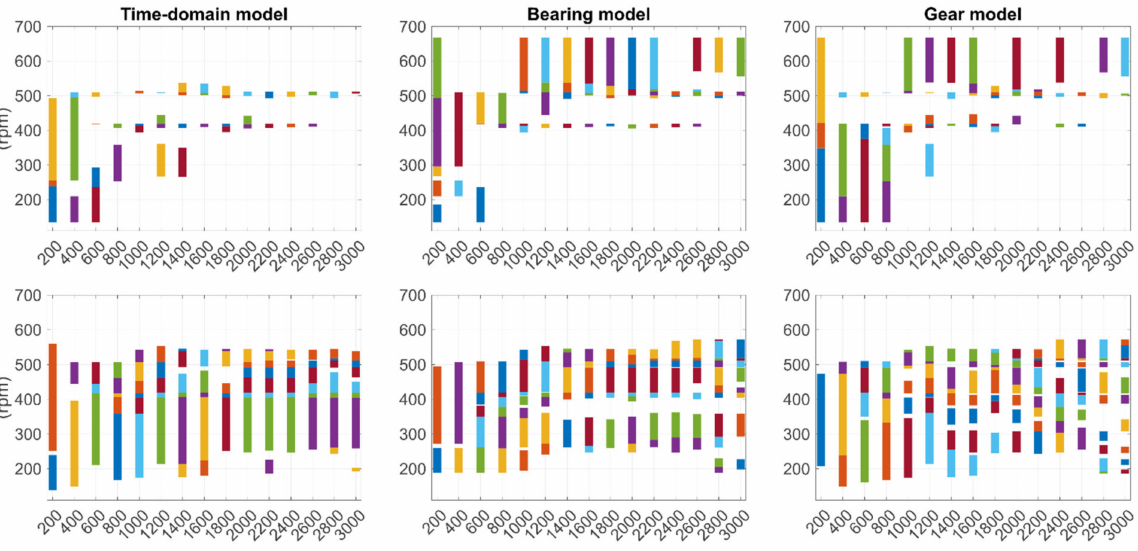
Figure A3. Selected shaft speed ranges for different models. ‘Basic training subsets’ approach was used on top, whereas ‘adaptive training subsets’ was used below. Values on horizontal axis represent the sample size (N) and the vertical lines with different colors represent selected non-overlapping